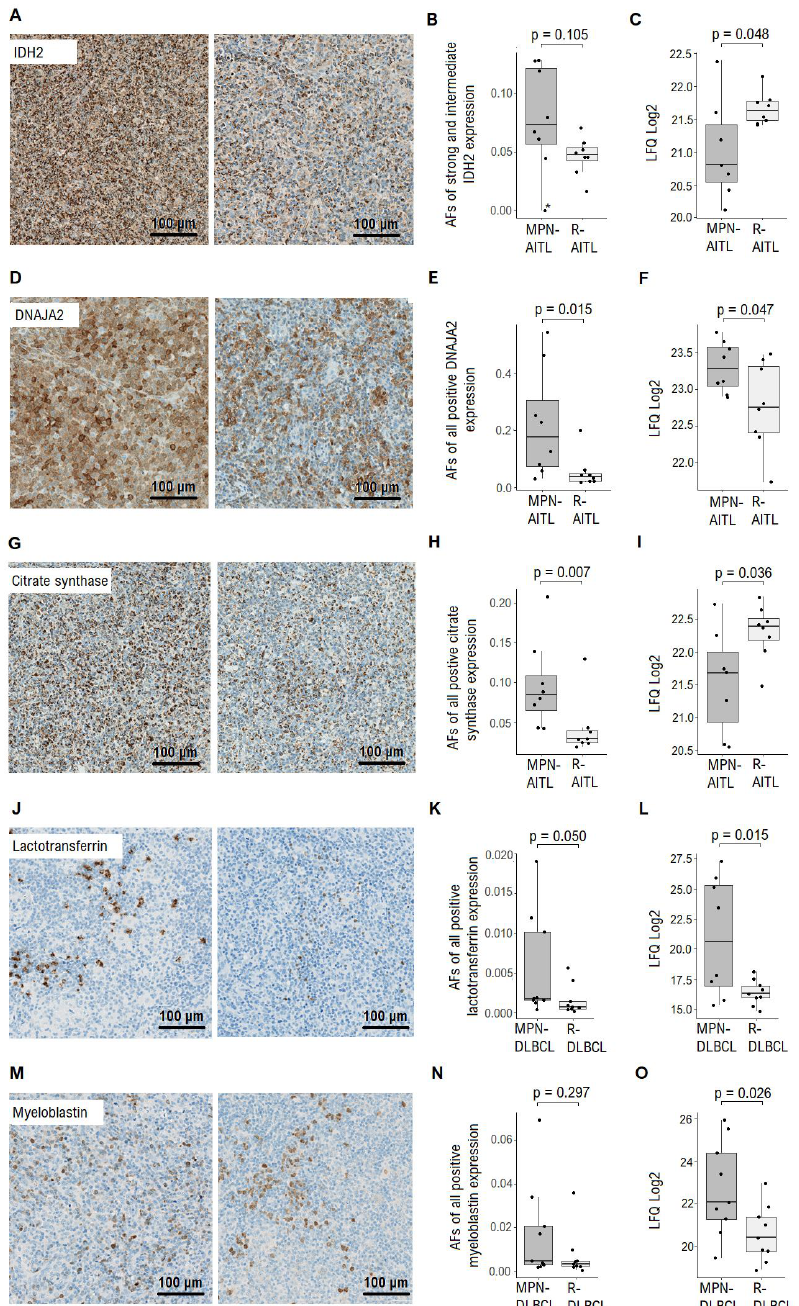
Figure 2. Immunohistochemical evaluation of selected proteins. ( A ) Representative images of IDH2 protein staining expression ( B ) AFs of strong and intermediate intensity staining of IDH2 protein. * denote MPN-AITL patient with two known IDH2 gene mutations. ( C ) IDH2 protein expression identified by MS-based proteomics analysis. ( D ) Representative images of DNAJA2 staining expression. ( E ) AFs of all positive DNAJA2 protein staining. ( F ) DNAJA2 protein expression identified by MS-based proteomics analysis. ( G ) Representative images of citrate synthase staining expression. ( H ) AFs of all positive citrate synthase staining. ( I ) Citrate synthase protein expression identified by MS-based proteomics analysis. ( J ) Representative images of lactotransferrin staining expression. ( K ) AFs of all positive lactotransferrin staining. ( L ) Lactotransferrin protein expression identified by MS-based proteomics analysis. ( M ) Representative images of myeloblastin staining expression. ( N ) AFs of all positive myeloblastin staining. ( O ) Myeloblastin protein expression identified by MS-based proteomics analysis. Abbreviations: AF, area fraction; AITL, angioimmunoblastic T-cell lymphoma; DLBCL, diffuse large B-cell lymphoma; DNAJA2 , DnaJ homolog subfamily A member 2; IDH2 , isocitrate dehydrogenase 2; LFQ, label free quantification; MPN, myeloproliferative neoplasia; R-, reference